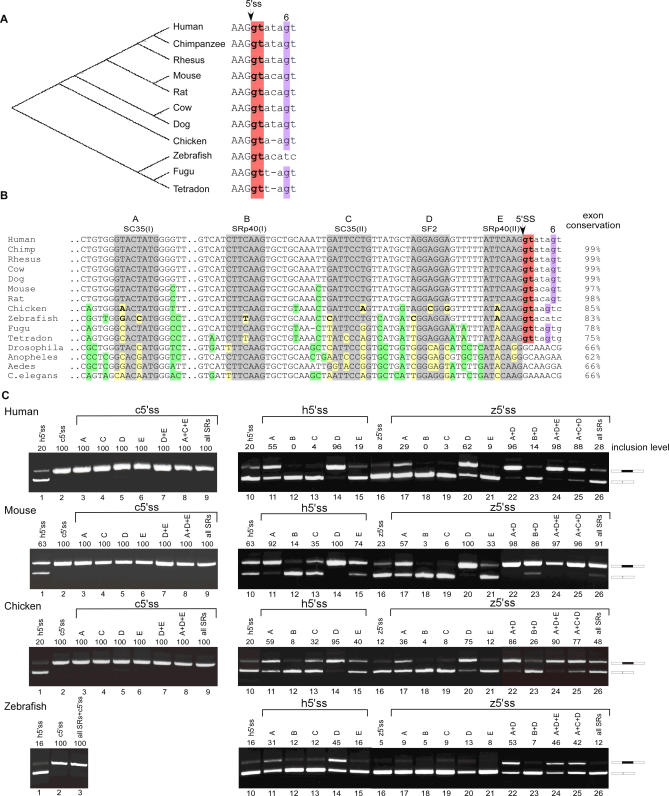
Mutations That Weaken the 5′ss during Evolution Shift Splicing from Constitutive to Alternative(A) Multiple alignment of the 5′ss of exon 5 of the SLC35B3 gene from 11 vertebrates was constructed, substitutions were analyzed based on the known evolutionary tree [44]. The first two intronic nucleotides are highlighted in red and evolutionary shift of the G from position 5 to 6 at the 5′ss is highlighted in purple. The gap indicates a potential insertion event. (B) Alignment of exon 5 of the SLC35B3 gene among 15 different organisms. The first two nucleotides of intron 5 are highlighted in red (the last four species do not contain this intron). As above, the shift of the G from position 5 to 6 among those organisms in the 5′ss is highlighted in purple. The examined five ESRs are highlighted in gray and marked A to E, with the name of the putative SR protein that binds that sequence noted in the upper part of the panel. Nucleotides that are highlighted in yellow and green show exonic positions that were changed during evolution (with respect to the human sequence) inside the five ESRs and outside of those sites, respectively. The nucleotides that were mutated in our experiments are in bold (see Table S4). (C) The indicated WT and mutated SLC35B3 minigenes were transfected into human 293T, mouse NIH 3T3, chicken DF-1 cell-lines, or injected into 1-day-old zebrafish embryos (as marked on the left). Total RNA was collected and analyzed by RT-PCR with plasmid-specific primers and, after RT-PCR, by DNA sequencing. The two mRNA isoforms are shown on the right. Numbers on top indicate percentage of exon inclusion as determined by ImageJ (100% corresponds to the total of both mRNA isoforms). 5′ss sequences identical to human, chicken, and zebrafish are indicated by h, c, and z, respectively.